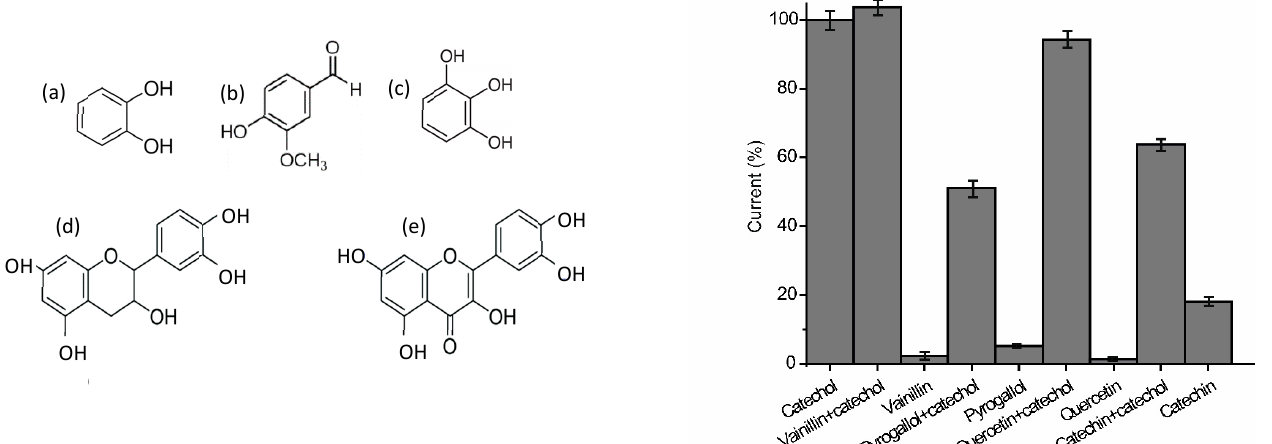
Figure 8. Left: Phenols included in the study, ( a ) catechol, ( b ) vainillin, ( c ) pyrogallol, ( d ) catechin and ( e ) quercetin. Right: Cathodic maximum peak intensity obtained immersing the AgNWs-Tyr sensor in 10 − 4 M catechol (in 0.01 mol·L − 1 PBS pH 7.0) in the presence of interfering phenols.